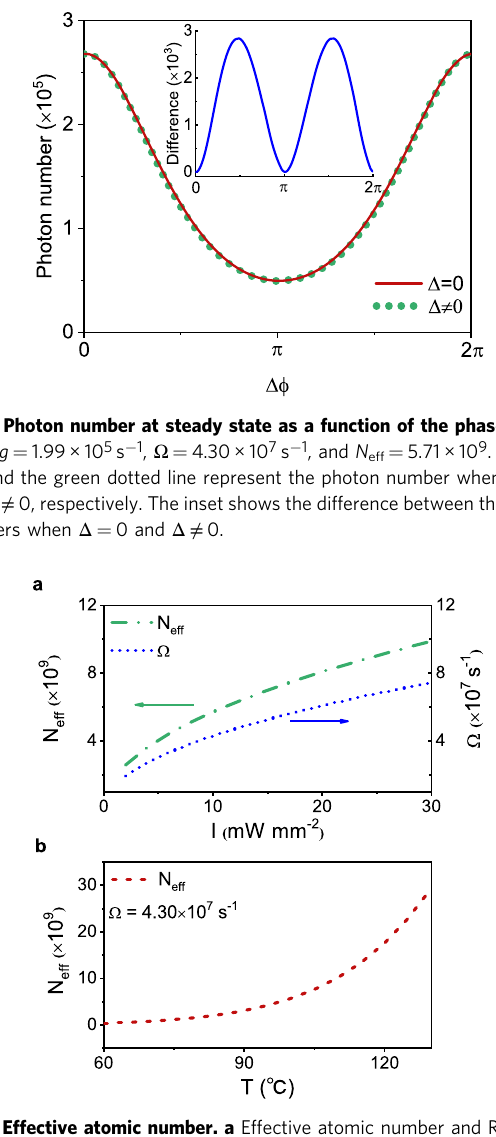
Fig. 7 Effective atomic number. a Effective atomic number and Rabi frequency vs. the pumping light intensity at a vapor-cell temperature of 100 ∘ C. b Effective atomic number as a function of the vapor-cell temperature under a pumping light intensity of 10 mW mm − 2 .